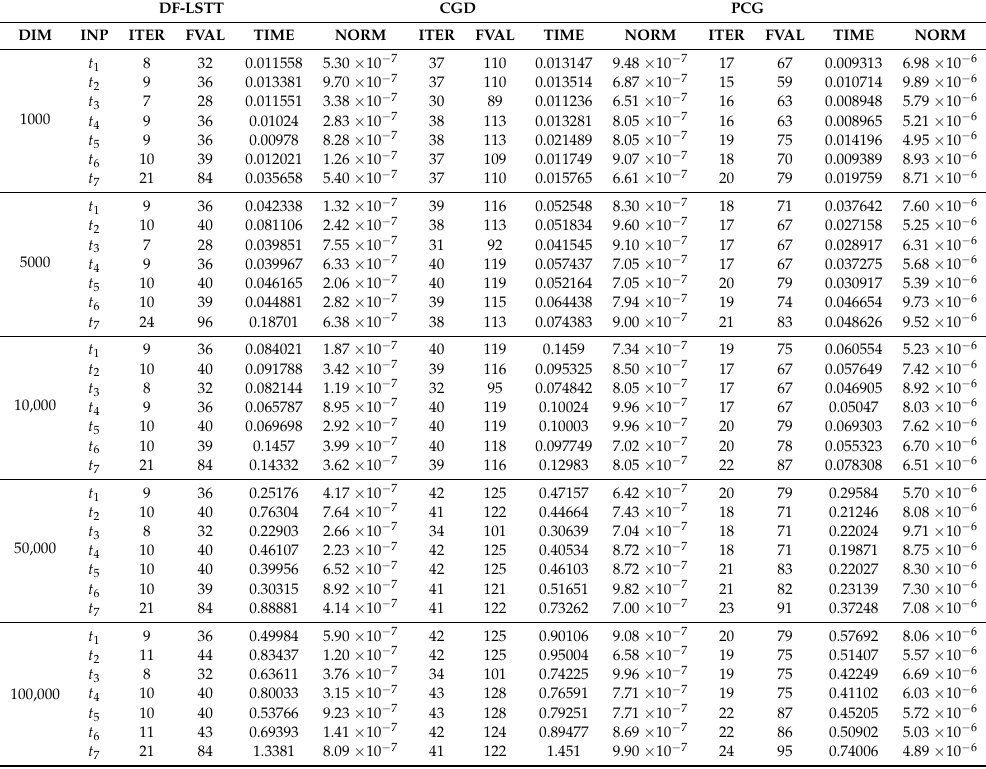
Table 9. Numerical test reports for the three tested methods for Problem